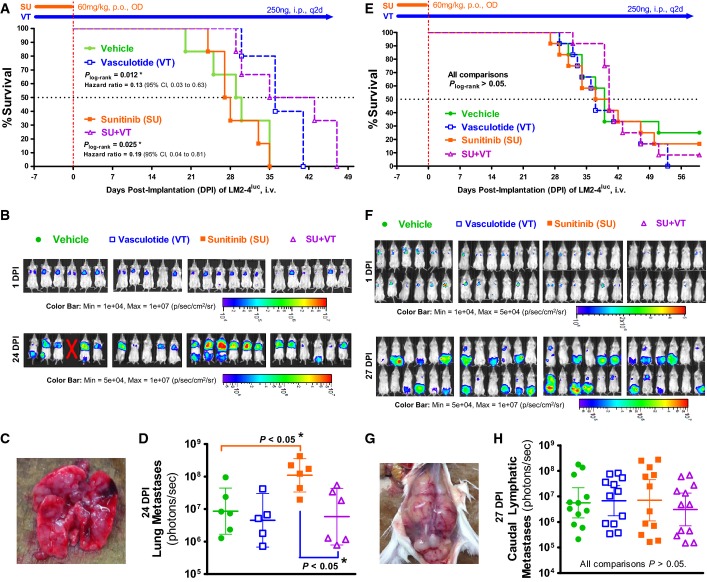
Vasculotide delays progression of experimental lung metastases but not lymphatic metastases from a human breast cancer cell line (LM2-4luc)

A–H LM2-4luc tumor cells were implanted intravenously into SCID mice, generating predominantly lung-specific metastases in one experiment (n = 5–6; A–D) and predominantly lymphatic-specific metastases in another experiment (n = 12; E–H). (C and G) Photographs of typical metastases in the lungs and caudal lymphatics, respectively. Kaplan–Meier survival analysis showed that Vasculotide (VT) significantly delayed mortality due to lung metastases (A) but not lymphatic metastases (E). Quantitative analysis of in vivo bioluminescent images taken at 24DPI (B) showed that concurrent VT treatment effectively reversed the sunitinib (SU)-induced acceleration of lung metastases (D). With regard to lymphatic metastases (F, H), SU treatment did not accelerate their progression. Geometric means ± 95%CI are depicted in (D and H); P values were derived by one-way ANOVA (D) and Kruskal–Wallis test (H). The same trends were reproduced in confirmatory experiments summarized in Supplementary Fig S5.